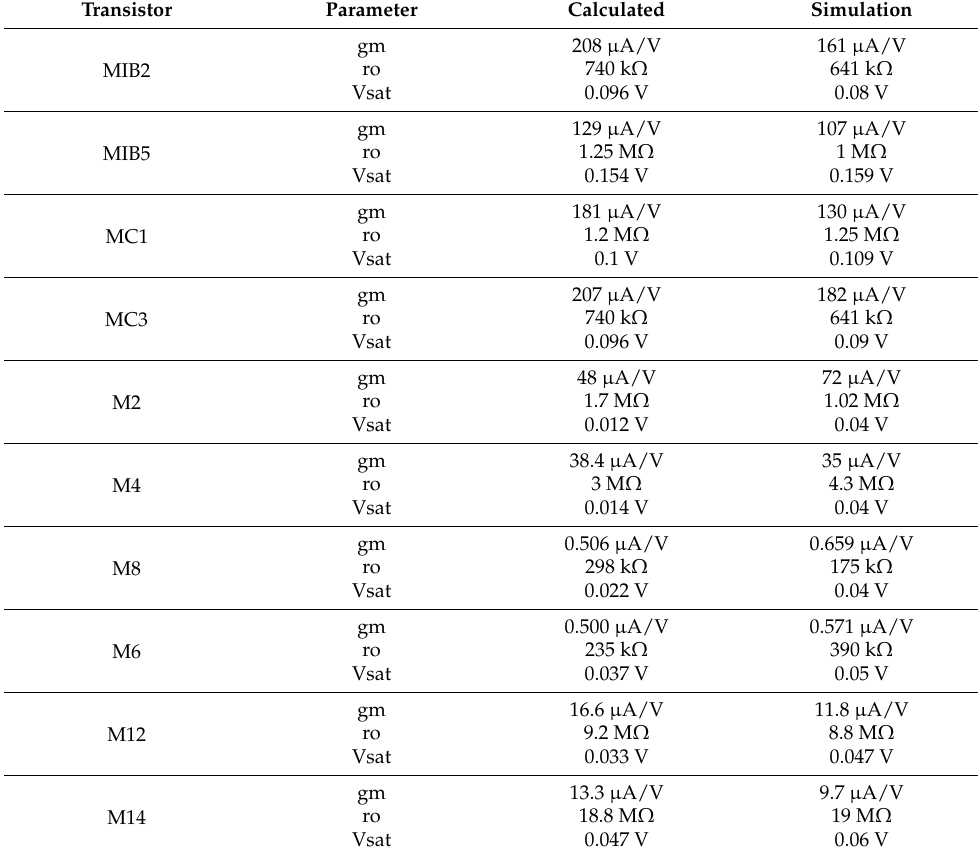
Table 2. Transistors calculated and simulated small signal parameters used in the